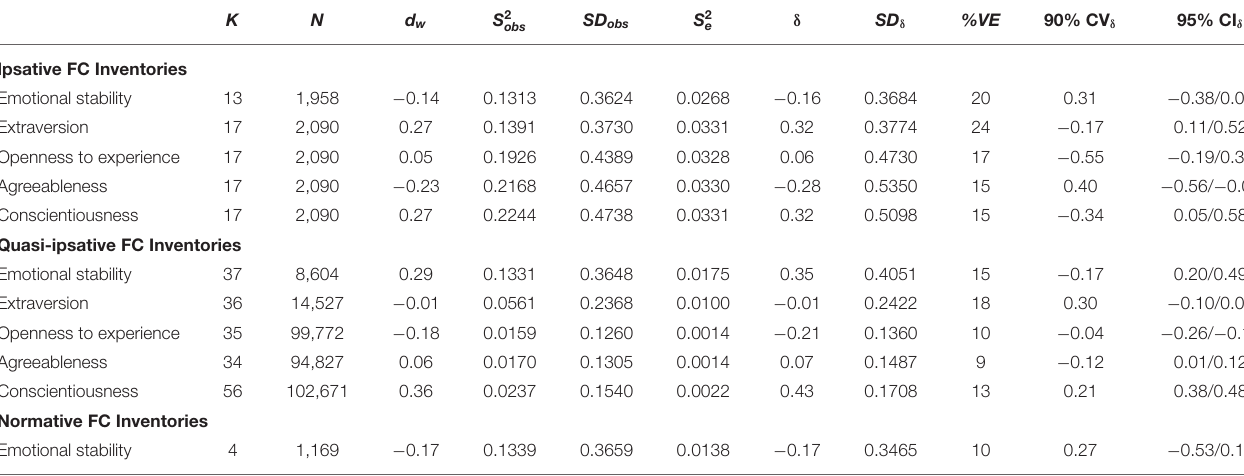
TABLE 3 | Meta-analysis of the faking resistance of forced-choice inventories by type of forced-choice